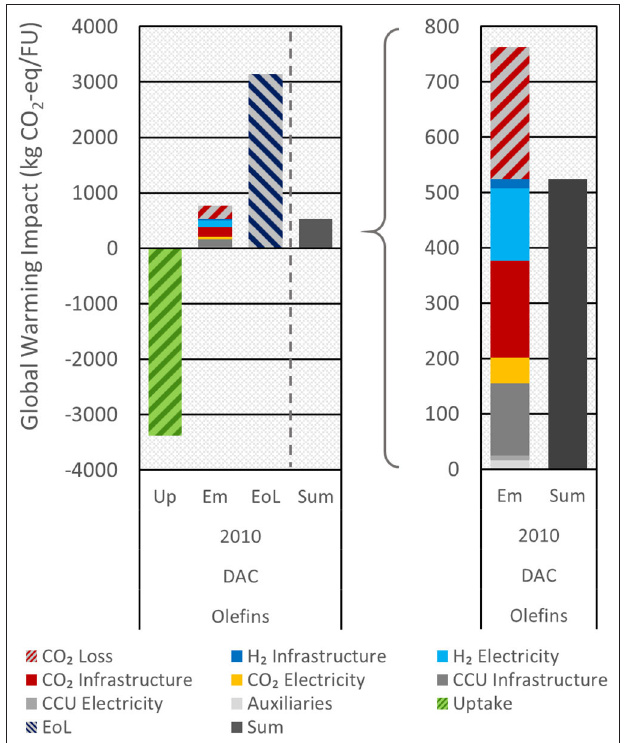
FIGURE 2 | Reading example of GWI results. GWI values comprise the following contributions: Uptake (Up) of CO 2 entering the system (“negative” emission) due to the 100:0 allocation; process emissions (Em) within the system; stoichiometrically calculated end-of-life (EoL) CO 2 emissions after combustion of the product; summarized value (Sum) of all contributions, representing C2G + EoL. For simplification, only process emissions (Em) and summarized values (Sum) will be shown, as “Uptake,” “CO 2 Loss,” and “EoL” always add up to